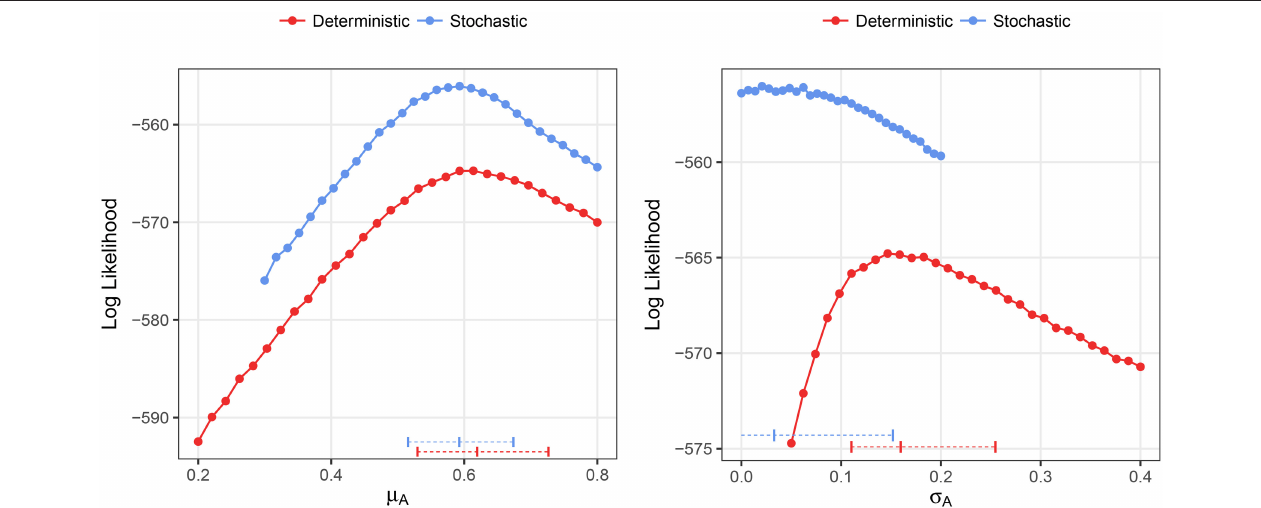
FIGURE 10 | Profile likelihood plots for the parameter estimates for the Ebola data. The plot on the left shows the profile likelihood for the mean growth rate, µ A , while the plot on the right shows the profile likelihood for the standard deviation of growth rates over counties, σ A . Horizontal dashed lines indicate the MLE and 95% CIs for the parameter estimates. The overdispersion parameter was free to vary in the calculation of each point along the